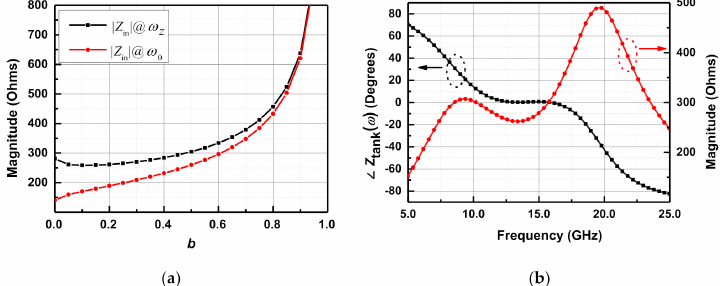
Figure 6. ( a ) Magnitude plots of the tank impedance at ω z and ω 0 versus b. ( b ) Phase (black) and magnitude (red) responses of the tank are shown in Figure 3a, where L p , L s , C p , C s , and R p are 2 nH, 2 nH, 100 fF, 50 fF, and 130 Ohms,